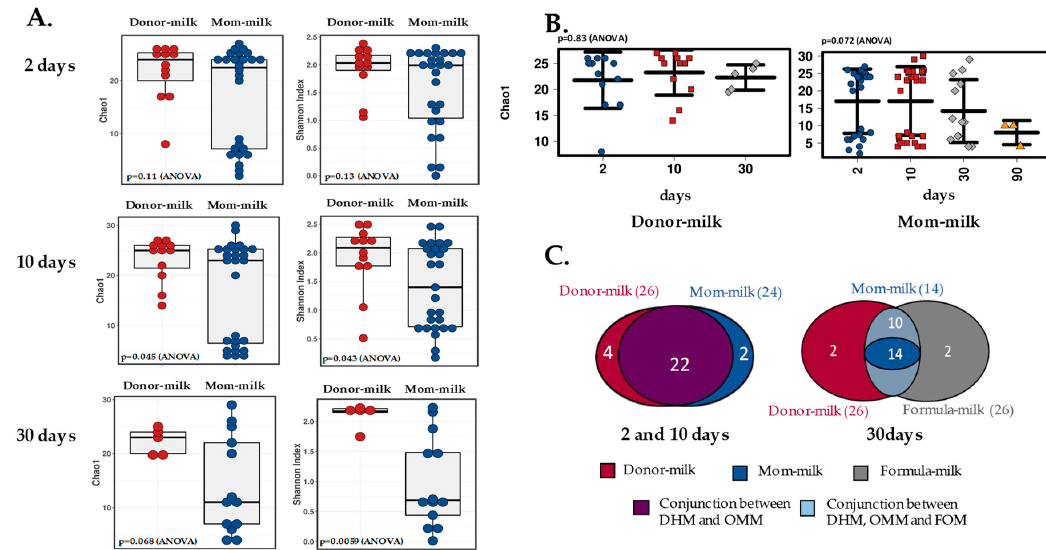
Figure 2. Bifidobacterium diversity. ( A ) Alpha diversity between groups. Chao1 and Shannon index comparisons between the DHM and OMM milk groups at 2 ( n = 12 and n = 26, respectively), 10 ( n = 12 and n = 27, respectively), and 30 ( n = 5 and n = 13, respectively) days of life. ( B ) Alpha diversity over time. Chao1 index over time comparison in the DHM and OMM milk groups ( n = 3 at 90 days). ( C ) Venn diagram. Number of unique and shared species in the babies’ groups over time. Colors and groups are explained in each figure.